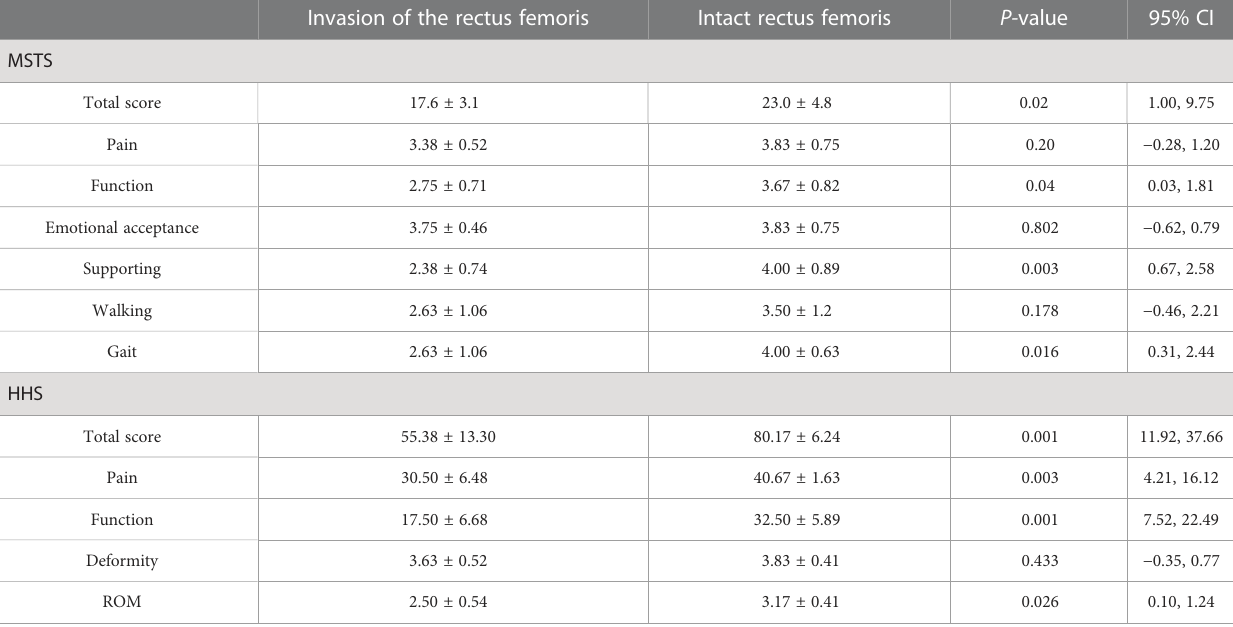
TABLE 3 Functional outcomes of the included patients strati fi ed by invasion of the rectus femoris or an intact rectus femoris. Invasion of the rectus femoris Intact rectus femoris